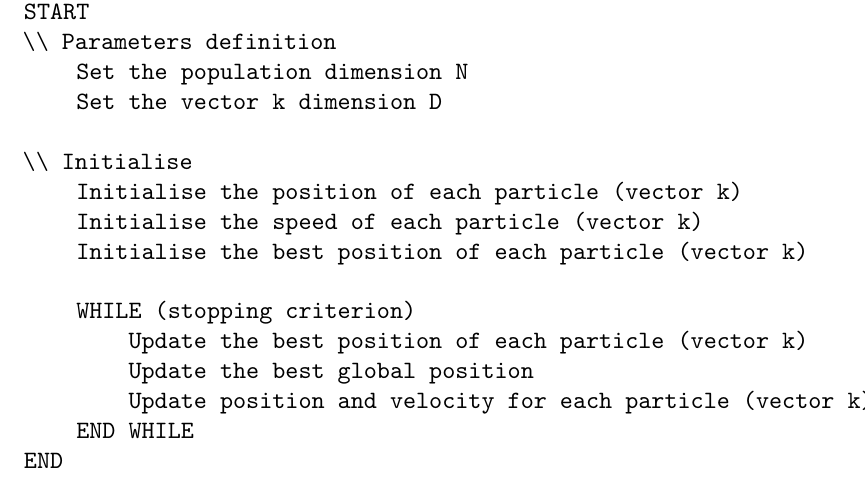
Figure 4. Pseudo-code for PSO algorithm, as taken from [41]. Grey Wolf Optimization. If PSO was generically inspired by birds’ and fishes’